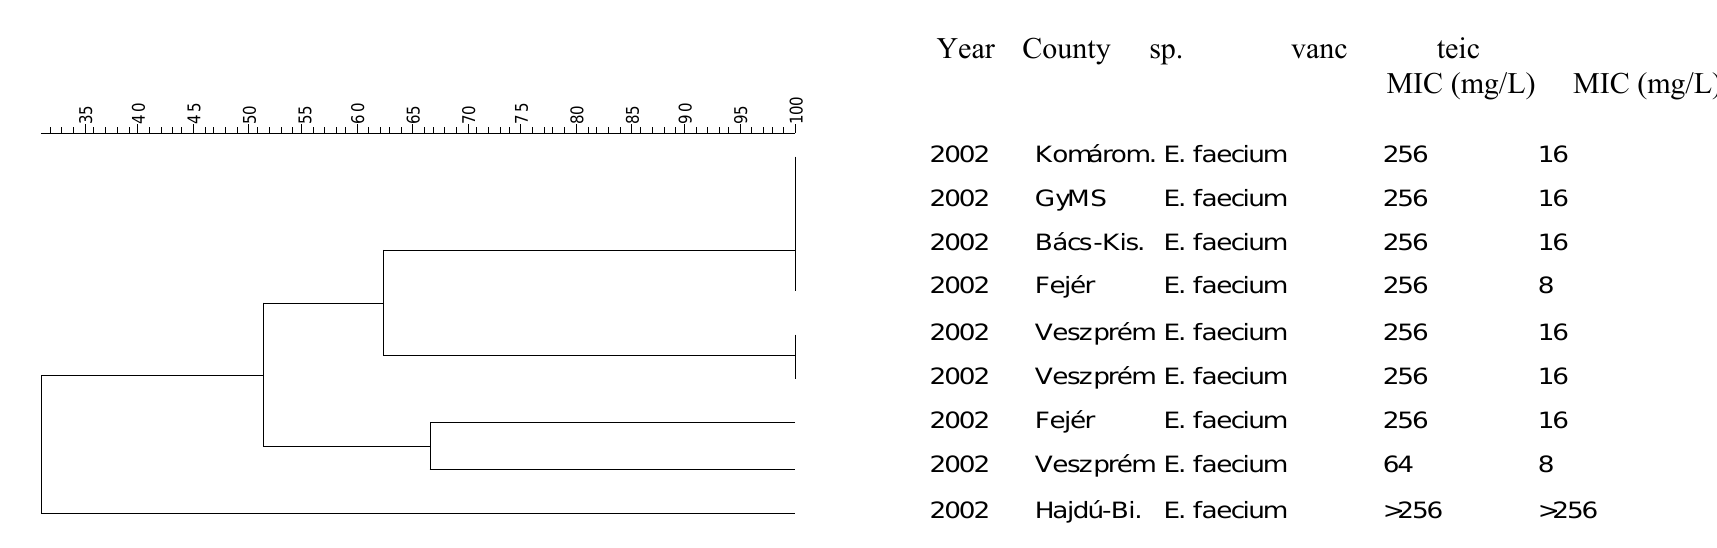
Dice (Opt:1.00%) (Tol 2.0%-2.0%) (H>0.0% S>0.0%) [0.0%-100.0%]